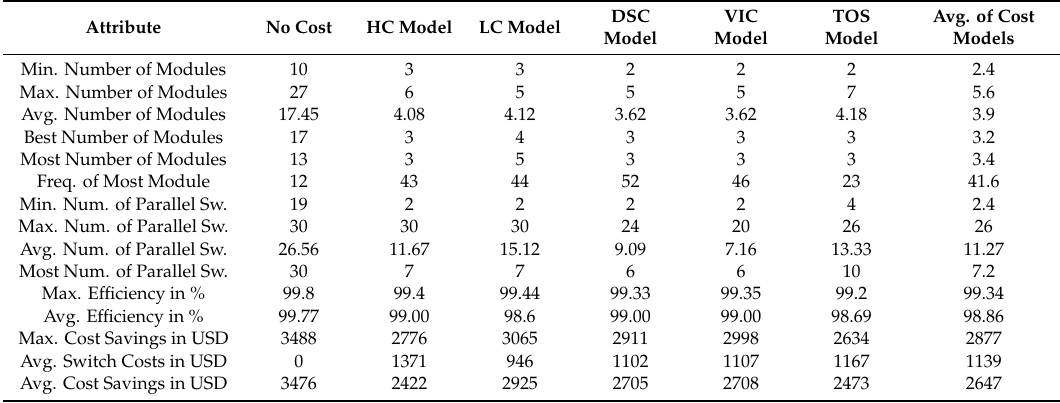
Table 2. Summary of the main results in the di ff erent